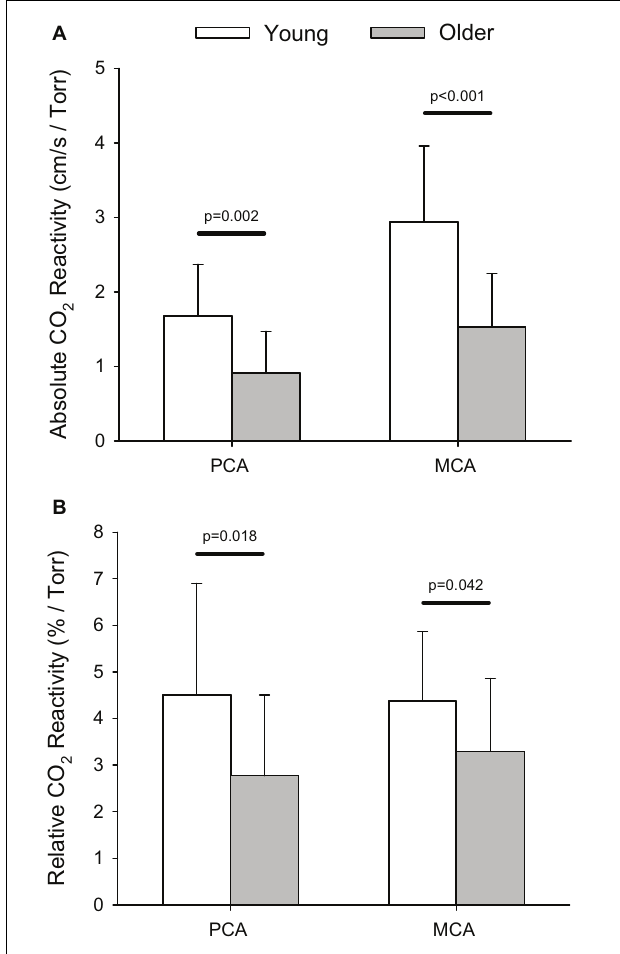
FIGURE 4 | Absolute (i.e., cm/s/Torr; A) and relative (i.e., %/Torr, B) reactivity for posterior (PCA) and middle cerebral artery (MCA) blood velocity in response to the hypercapnic test. P -values provided for comparison between young and older volunteers.